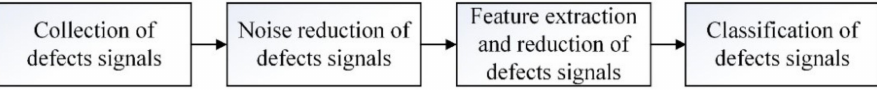
Figure 7. Diagnosis procedure flow chart of the steel cord conveyor belt defects